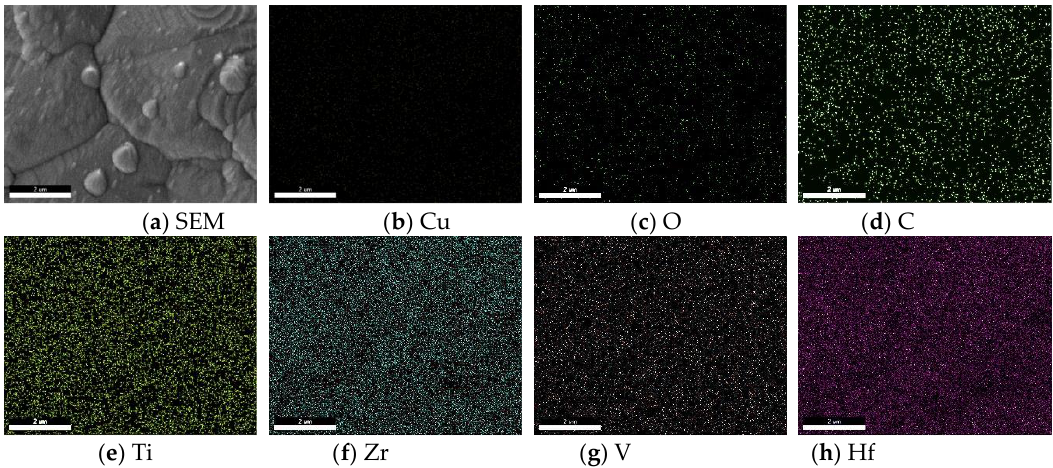
Figure 4. The surface SEM images of the Ti-Zr-V-Hf film with OCMF substrates ( a ) and corresponding Cu ( b ), O ( c ), C ( d ), Ti ( e ), Zr ( f ), V ( g ) and Hf ( h ) distribution maps. Scale bar 2 µ m.